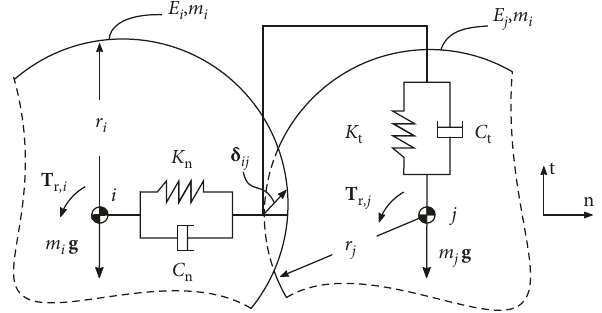
Figure 3: Contact